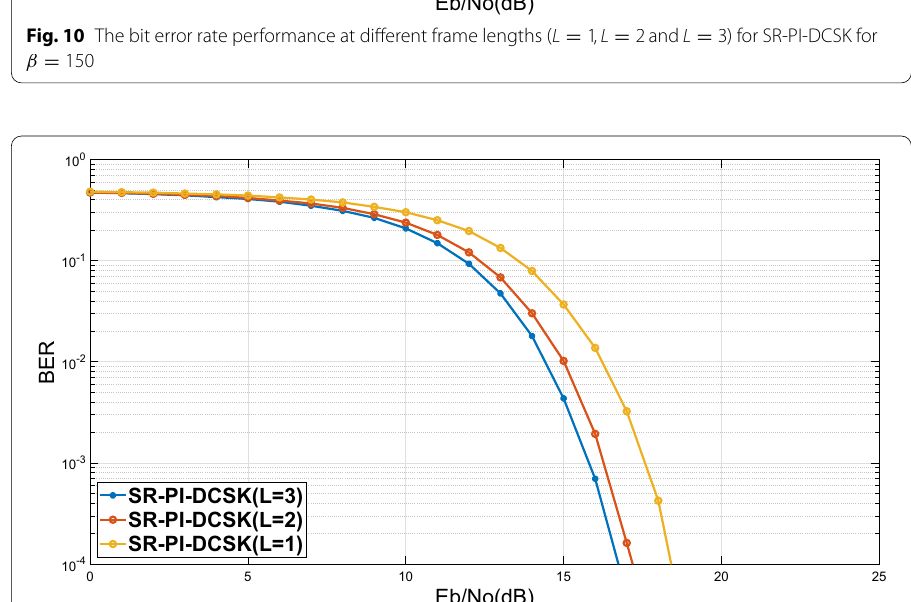
Fig. 11 The bit error rate performance at different frame lengths ( L = 1 , L = 2 and L = 3 ) for SR‑PI‑DCSK